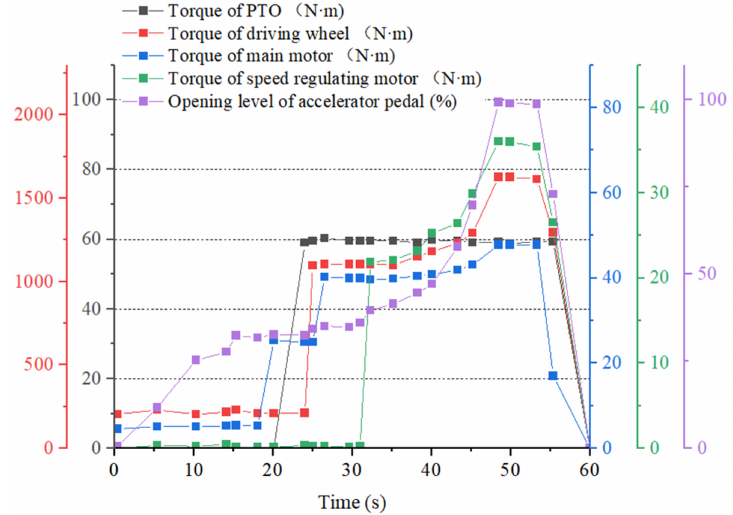
Figure 21. Curves of dynamic wheel equivalent torque, PTO load torque, main motor torque, speed control motor torque, and accelerator pedal opening.